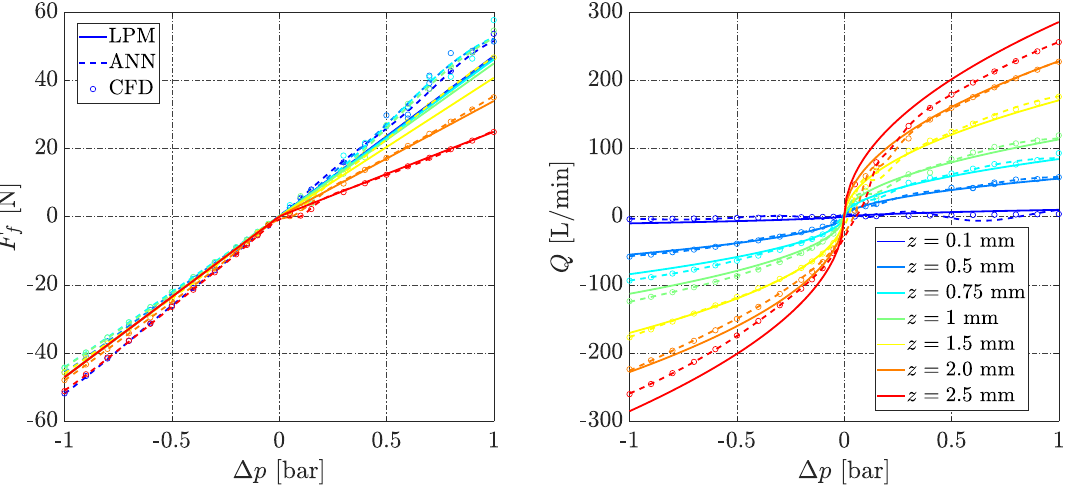
Figure 16: Same as in Figure 15 but with R = 15 mm & w = 5 mm.